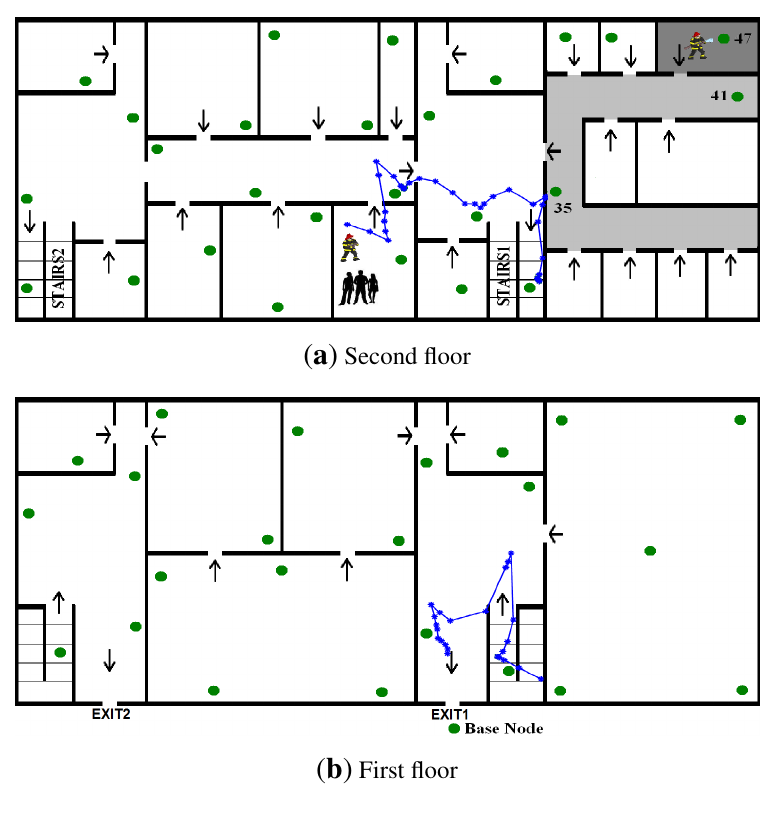
Figure 13. Maps of the second ( a ) and first ( b ) floors of the building with fire conditions and guiding information at time t . The trajectory followed by FIREMAN1 while escaping from 1 the building is also shown.